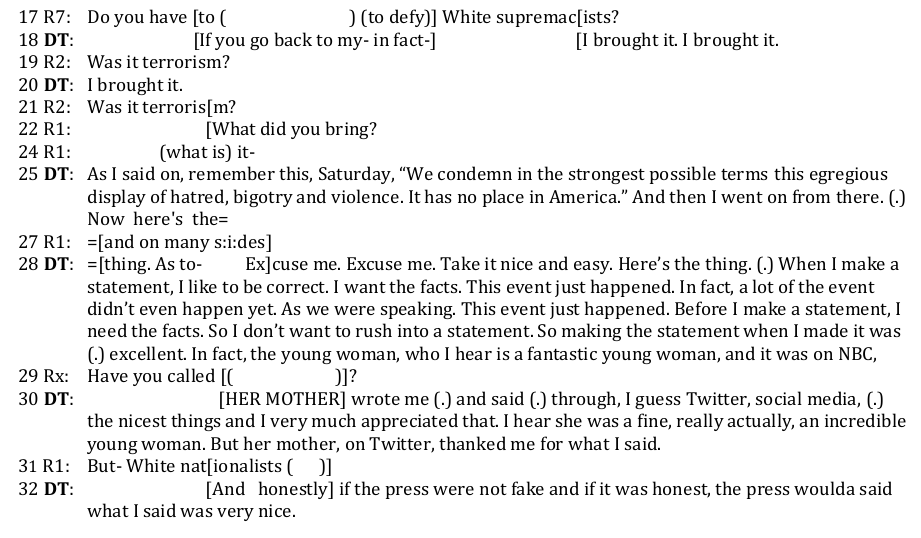
Figure 5. Transcript excerpt 17–32.